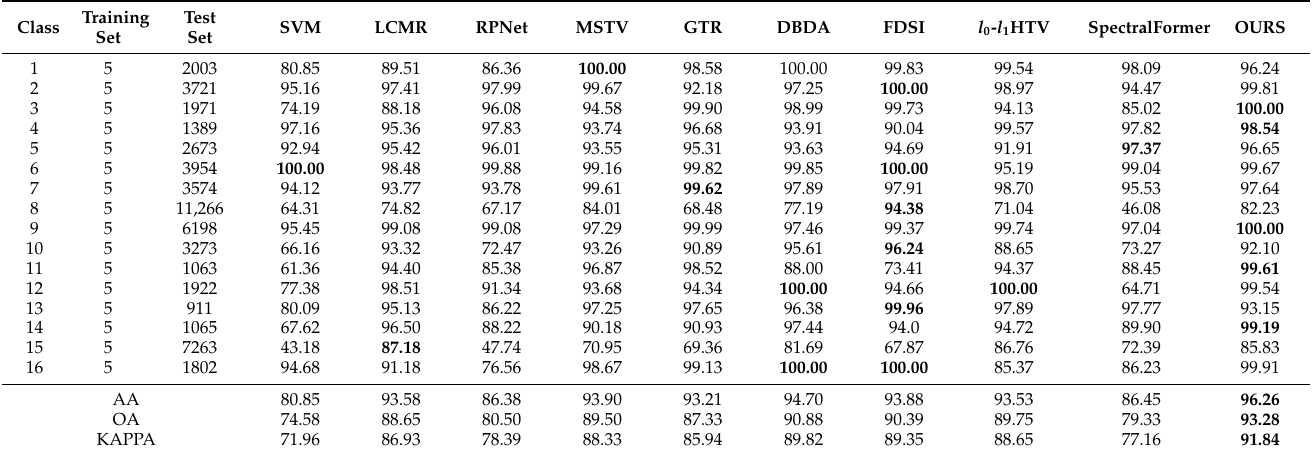
Table 4. Experimental results (%) on Salinas dataset obtained by different methods. The best results are highlighted in bold.